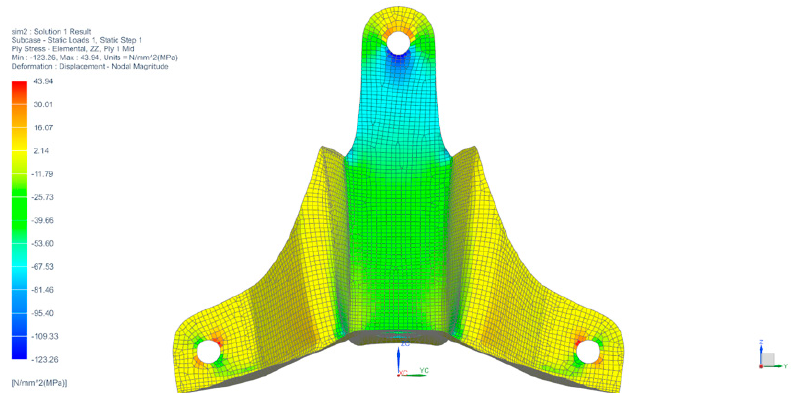
Figure 20. Stresses, σ zz obtained by FEM of the BFRP component.